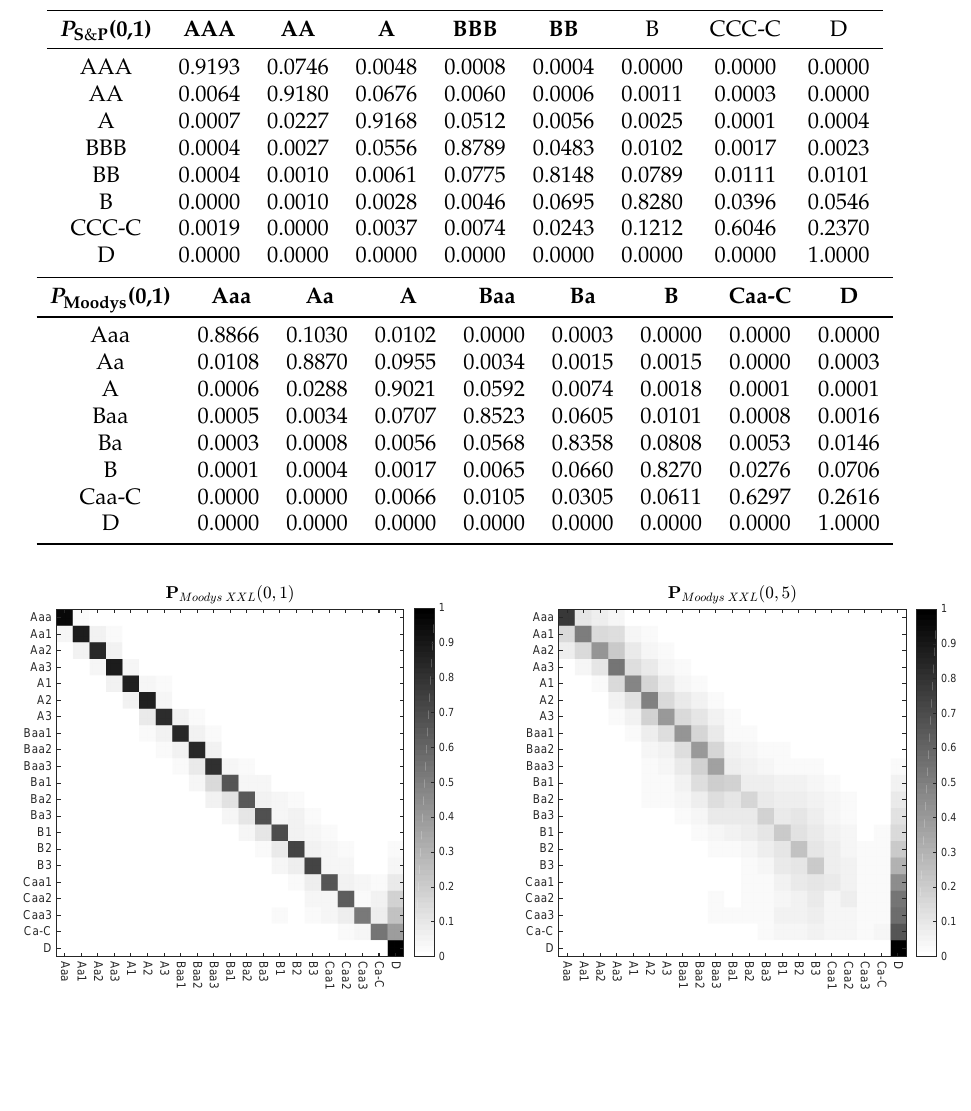
Table A2. Example of a resulting valid generator matrix based on BAM and (G1), (G2). G Moodys